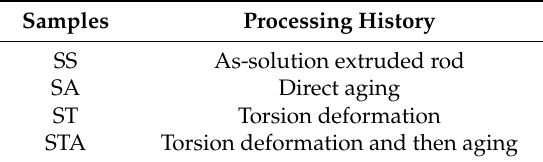
Table 1. Extruded AZ91 rods subjected to various processing